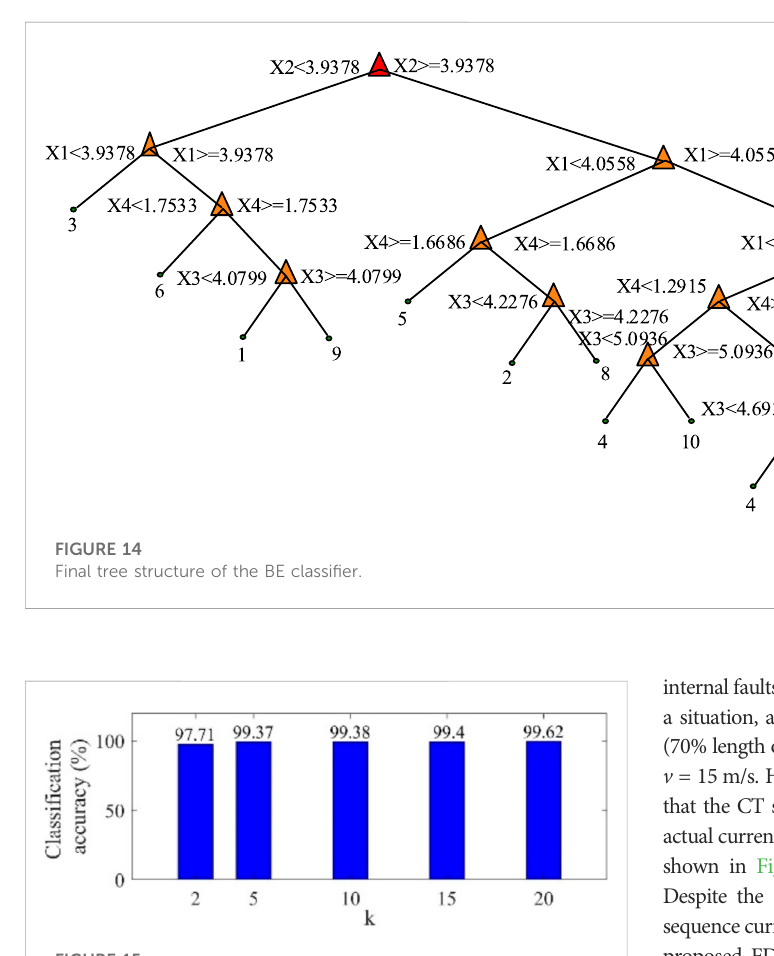
FIGURE 15 Variation of fault classi fi cation accuracies with k